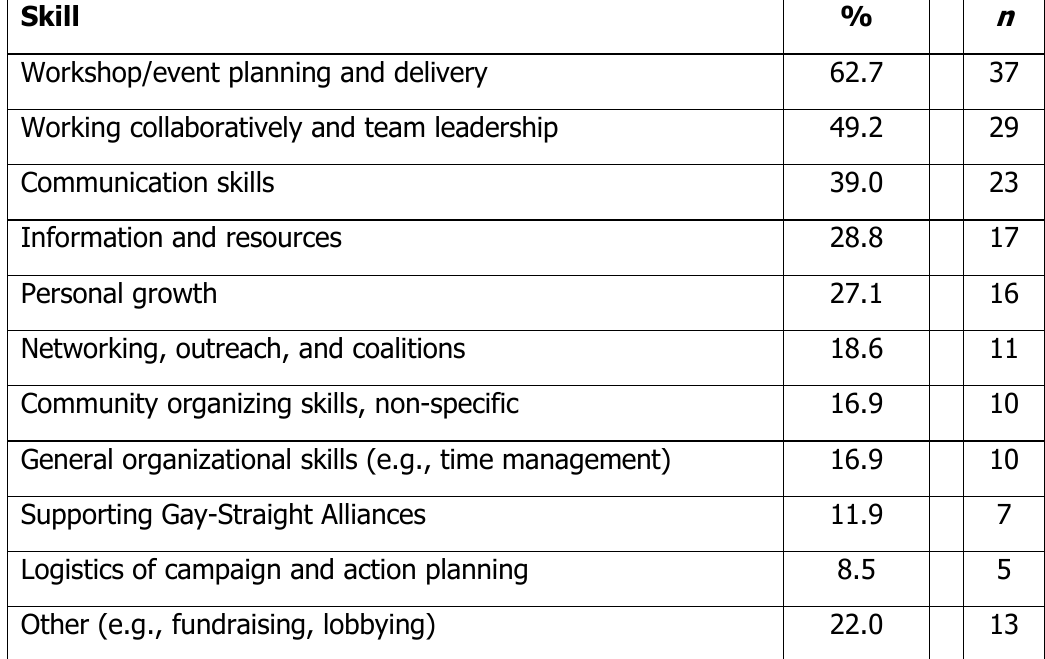
Self-Report of Skills Obtained Through Jump-Start Team Participation (n=59) Skill Workshop/event planning and delivery Working collaboratively and team